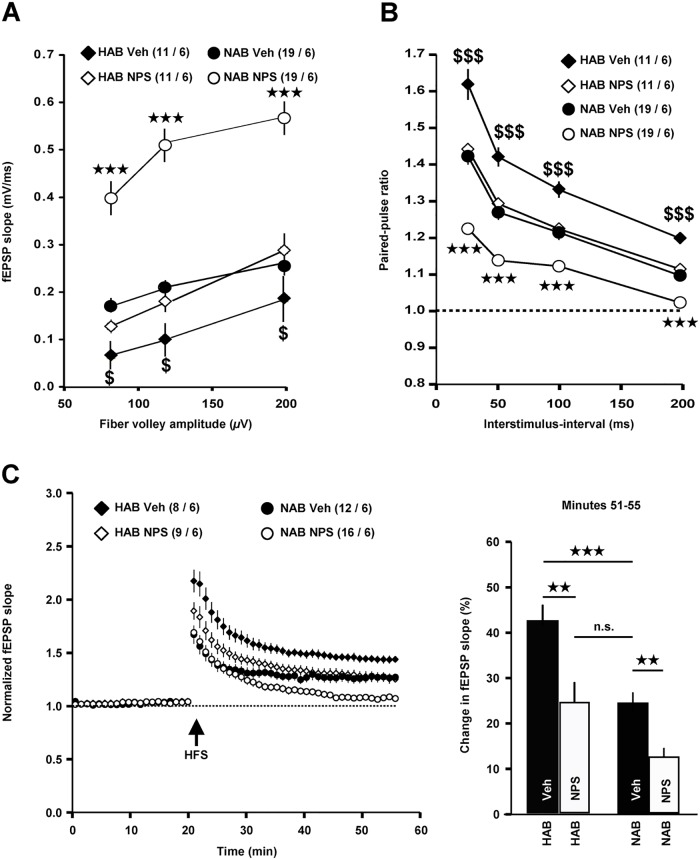
Intranasally applied NPS (open diamonds and open circles) causes enhanced basal neurotransmission (A) and reduced PPF (B) and LTP (C) at ventral CA3-CA1 synapses in HAB and NAB mice compared to Veh-treated (black diamonds and black circles) animals.
n numbers are indicated in brackets as follows (slices / animals). ★ Comparison NAB Veh vs. NAB NPS. $ Comparison HAB Veh vs. HAB NPS.